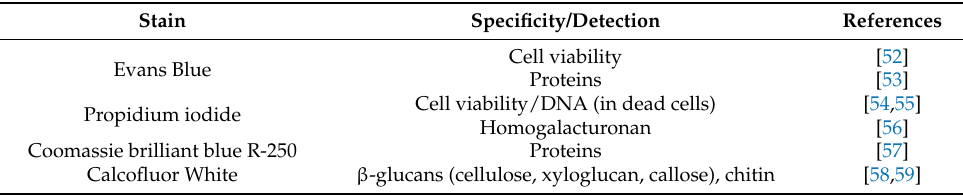
Table A1. Specification of the staining